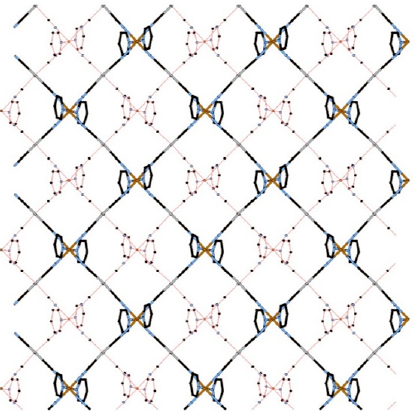
Figure 2. View of the bilayer of 1 (HS state) along the c axis (lower layer: red line, upper layer: cylinders). In this picture, the substituents of the ligands are omitted for clarity.